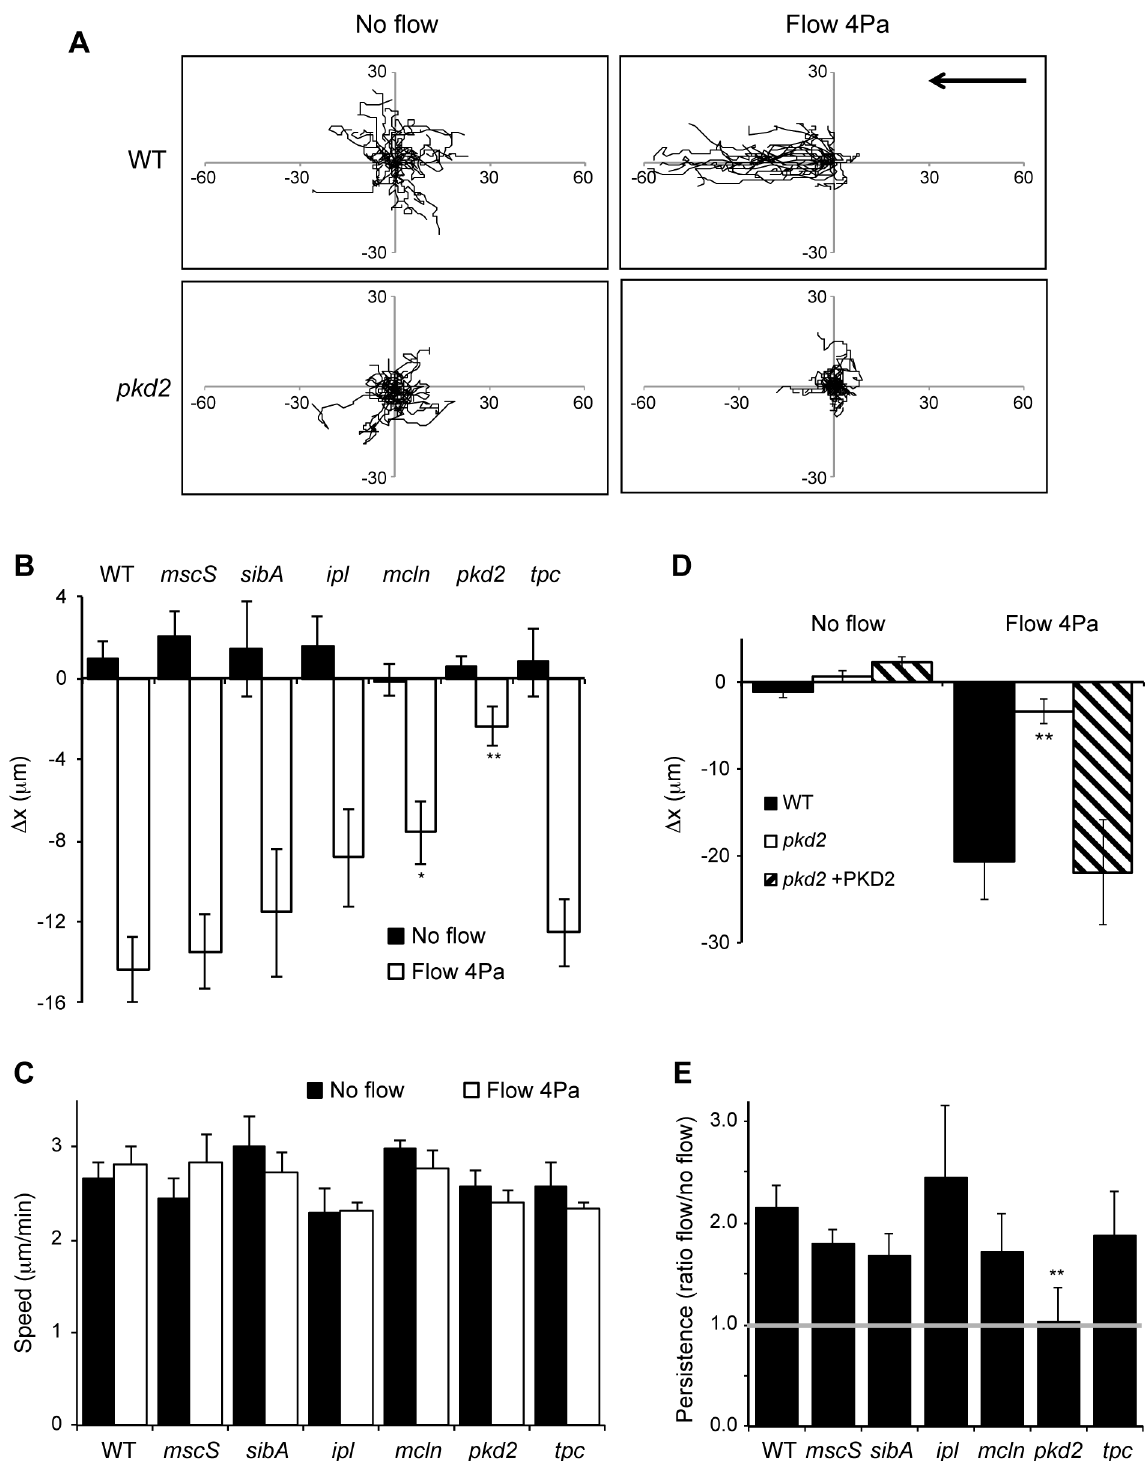
Figure 1. PKD2 is essential for shear-fluid stress response. A) Trajectories of WT and pkd2 KO cells migrating randomly (no flow) or subjected to shear flow stress (flow 4 Pa); cells were imaged every 15 sec for a total of 10 min, and the origins were set to 0. Axes indicate distances in m m. The arrow indicates the direction of the flow (from right to left). One representative experiment is shown. B) The directionality of cell migration was assessed by measuring the net displacement on the X axis ( D x). No significant difference between WT and KO cells was seen in control (no flow) condition. Under shear stress, mcln KO cells showed a significant reduction in orientation, while pkd2 KO cells were almost unable to orientate in the direction of the flow. * p , 0.05, ** p , 0.01, compared to WT values; n=5. C) The migration speed was calculated as the total distance migrated divided by the time ( m m/min). Speed was unchanged upon exposure to a shear stress, and no significant difference was seen between WT and KO cells; n=5. D) Expression of PKD2 in pkd2 KO cells restores the ability of cells to orientate relative to a shear flow. ** p , 0.01, compared to WT values;